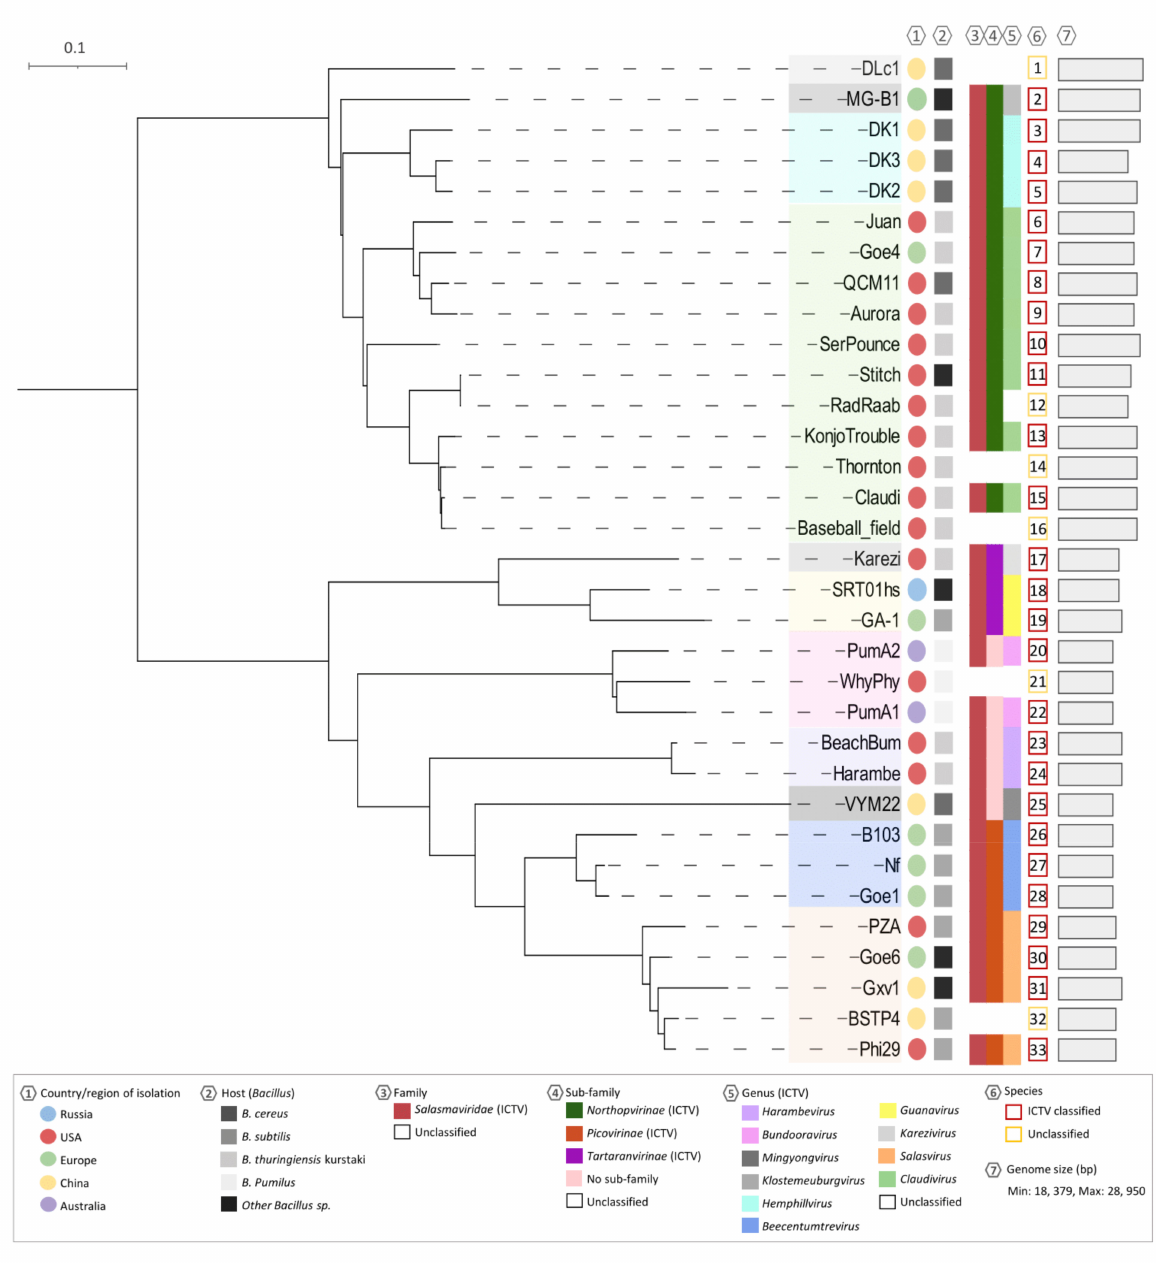
Figure 7. Phylogenetic tree using alignments of both DNA polymerase and encapsidation ATPase as candidate genes. The tree is rooted at midpoint and branches are supported by 100 bootstrap replicates. The colored shadings over each phage name indicate the clustering based off the other genomic comparisons; other metadata is defined in the legend. This clustering and color coding also correlate to the ICTV genus classifications. StevenHerd11 was eliminated from this tree due to its almost identical similarity to